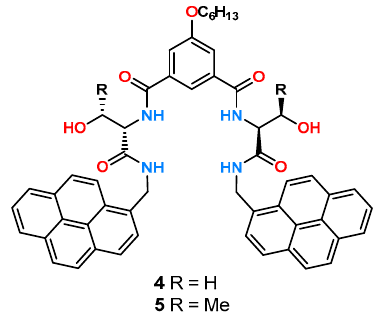
Figure 3. Tetraamide fluorescent receptors 4 (with serine) and 5 (with threonine). Symmetrically attached pyrene units were responsible for the fluorescence response, while the blocks introducing chirality were serine or threonine derivatives.